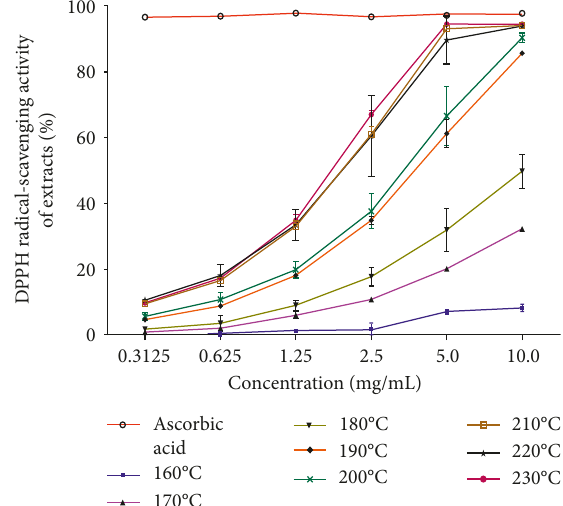
Figure 2: DPPH radical-scavenging assays of different aqueous extracts from okara by SWE and standard antioxidant (ascorbic acid). Data were expressed as mean licate samples.